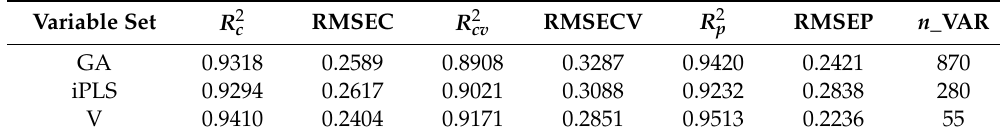
Figure 7. The frequencies of selected variables within 30 runs by the GA. Note: The selected wavelength is above the dotted line. Table 2. PLS model was established by different wavelength selection methods. Table 2. PLS model was established by di ff erent wavelength selection methods.